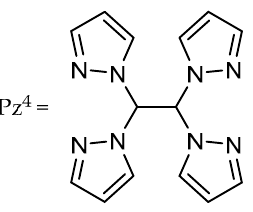
Figure 1. Bitopic 1,1,2,2-tetra(pyrazol-1-yl)ethane ligand (Pz 4 ).